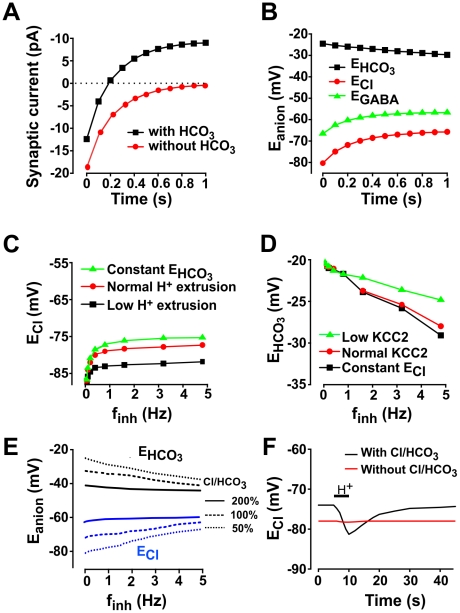
Trade-off between robustness of HCO3
− and Cl− homeostasis.
A. Change in synaptic current over time as GABAAR synapse is held open. Notice in the standard model (black) that current eventually inverted; in contrast, current decayed to zero but did not invert in the model without HCO3
− efflux (red). B. Change in reversal potentials over time for standard model and same test conditions as in A. Although small compared to changes in E
Cl, E
HCO3 did shift (in the opposite direction). The balance of those changes determines the net shift in E
GABA, which explains the functional implications of predictions tested in C and D – a reduced change in E
HCO3 should produce an enhanced change in E
Cl, whereas a reduced change in E
Cl should produce an enhanced change in E
HCO3. C. Encouraging HCO3
− efflux through GABAAR by holding [HCO3
−] constant (green) exacerbated the depolarizing shift in E
Cl. Discouraging HCO3
− efflux by reducing H+ extrusion to 33% of normal (black), which in turn discourages the forward reaction catalyzed by carbonic anhydrase and accelerates depletion of intracellular HCO3
−, mitigated the depolarizing shift in E
Cl. D. Conversely, encouraging Cl− influx through GABAAR by holding [Cl−] constant (black) exacerbated the hyperpolarizing shift in E
HCO3. Discouraging Cl− influx by reducing KCC2 activity to 10% of normal (green) mitigated the hyperpolarizing shift in E
HCO3. Effects in C were stronger than those in D, which illustrates how inter-relationships can be asymmetrical, i.e. pH regulation has a stronger impact on [Cl−] dynamics than Cl− regulation has on pH dynamics under the conditions simulated here. E. Simulations similar to the ones conducted in C and D were performed but with the addition of Cl−/HCO3
− exchanger at different levels of activity. F. We performed a simulation in which we added an artificial H+ influx for 5 s (horizontal bar). The proton influx caused a sizeable drop in [HCO3
−]i, thereby producing a hyperpolarizing shift in E
HCO3; that shift is greater in the model without the Cl−/HCO3
− exchanger (not shown). The resulting change in HCO3
− gradient caused an inversion of Cl−/HCO3
− exchange that led to a significant lowering of E
Cl; this did not occur in the absence of the Cl−/HCO3
− exchanger.